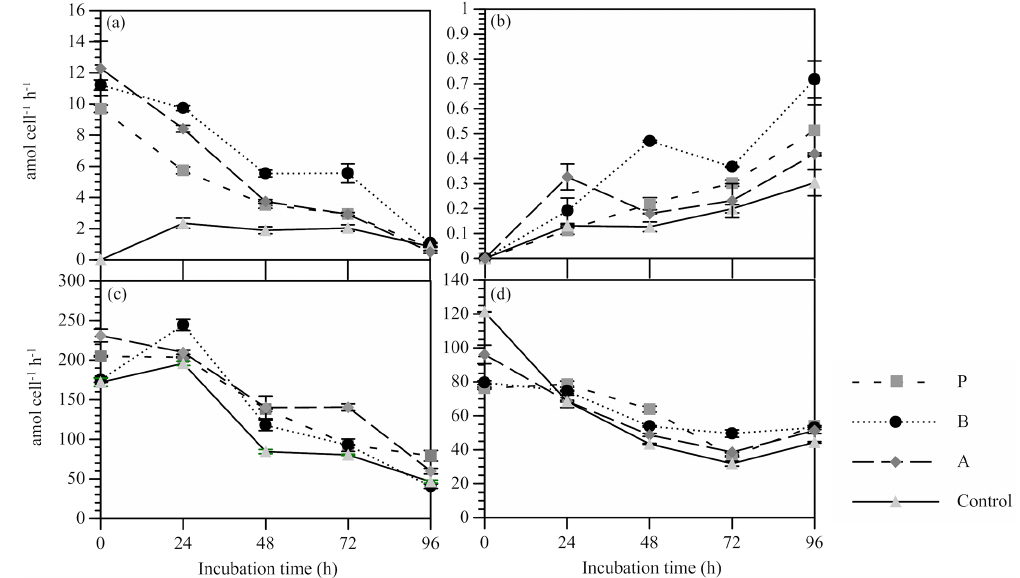
Figure 1. Cell-specific extracellular enzyme activity (mean ± SE, n = 3) in response to seawater acidified with 0.1 M HCl (A), bubbled with CO 2 –air gas mixture (B) and CO 2 –air gas mixture introduced through gas-permeable silicon tubing (P). (a) BG activity in trial 1; (b) BG activity in trial 2; (c) LAP activity in trial 1; (d) LAP activity in trial